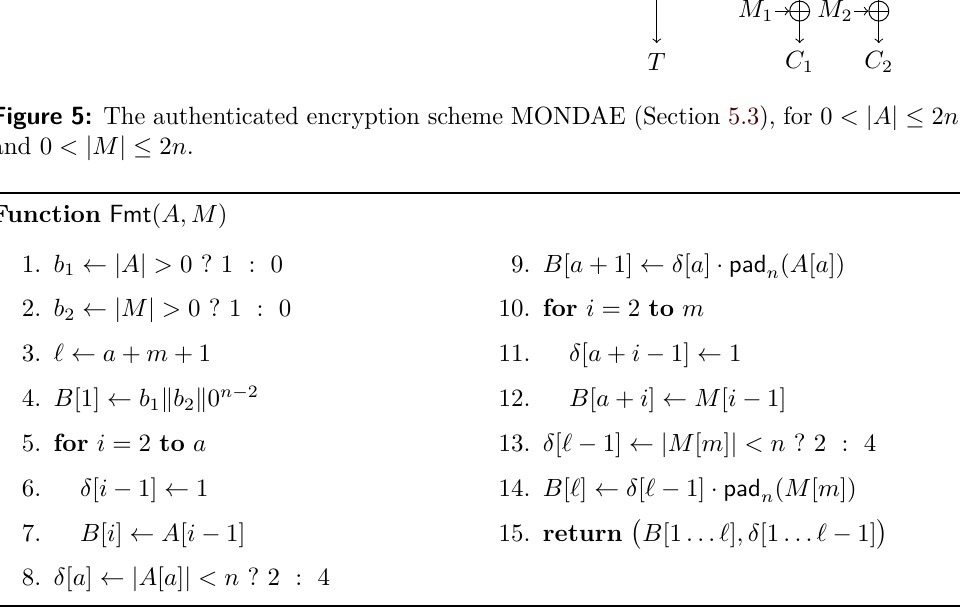
Figure 6: The formatting function Fmt of